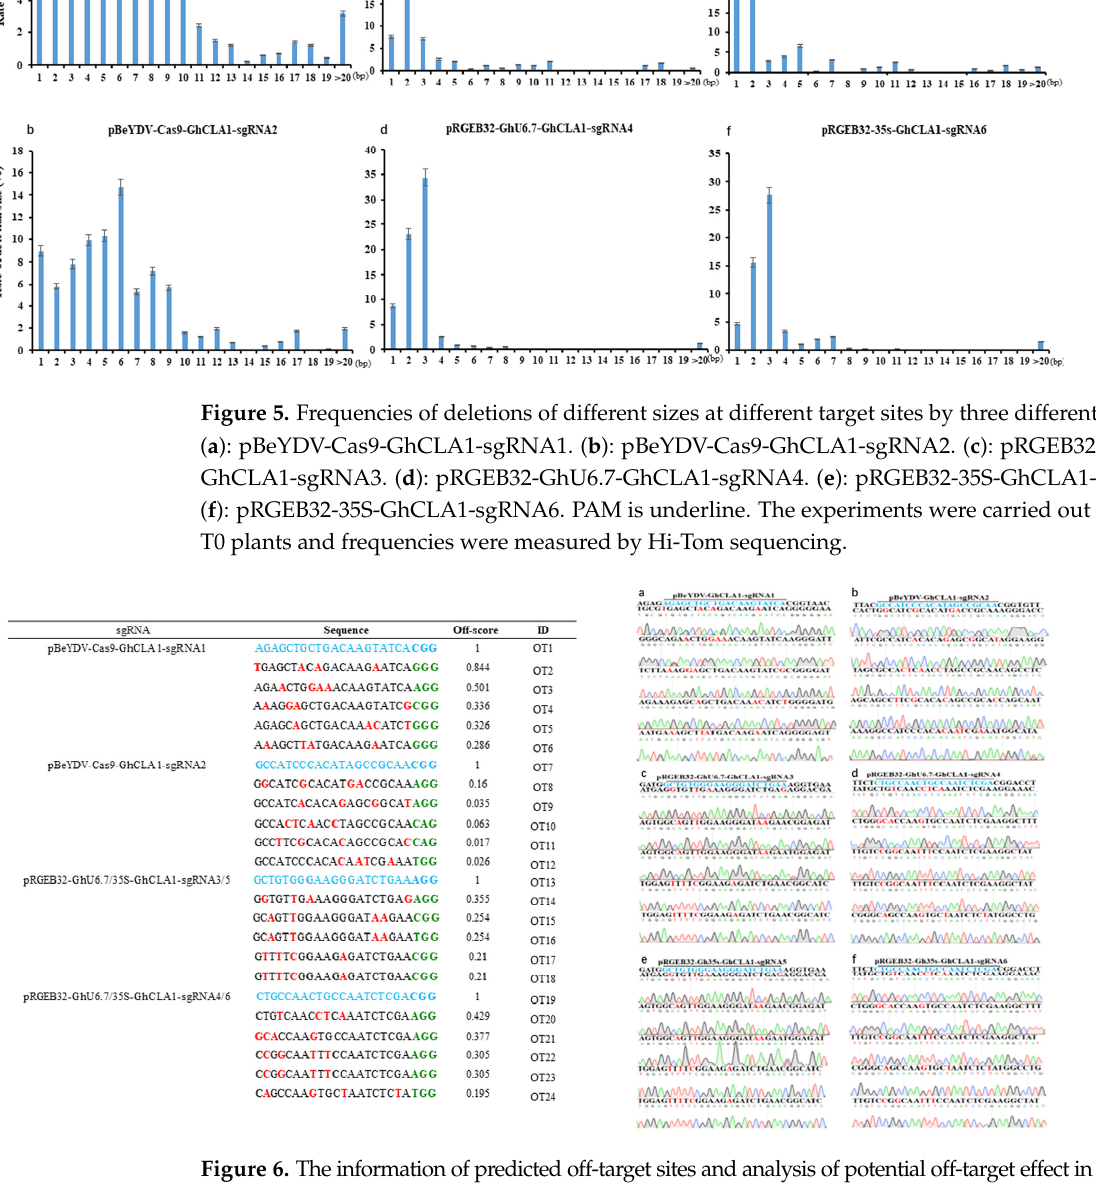
Figure 6. The information of predicted off-target sites and analysis of potential off-target effect in T0 plants using three systems. Off-target effects were detected at predicted potential off-target sites in independent T0 plants by Sanger sequencing. Five predicted potential off-target sites were selected for each target. Mismatching bases are shown in red; the PAM motifs are shown in green. Off-target effects were detected at five predicted potential off-target sites in six independent T0 plants by Sanger sequencing. pBeYDV-Cas9-GhCLA1 ( a , b ), pRGEB32-GhU6.7-GhCLA1 ( c , d ), pRGEB32-35S-GhCLA1 ( e , f ).